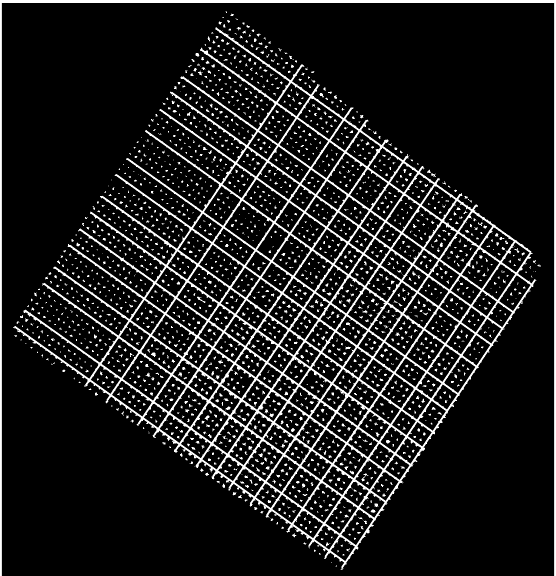
Figure 7. Hough lines drawn along some of the vine columns and